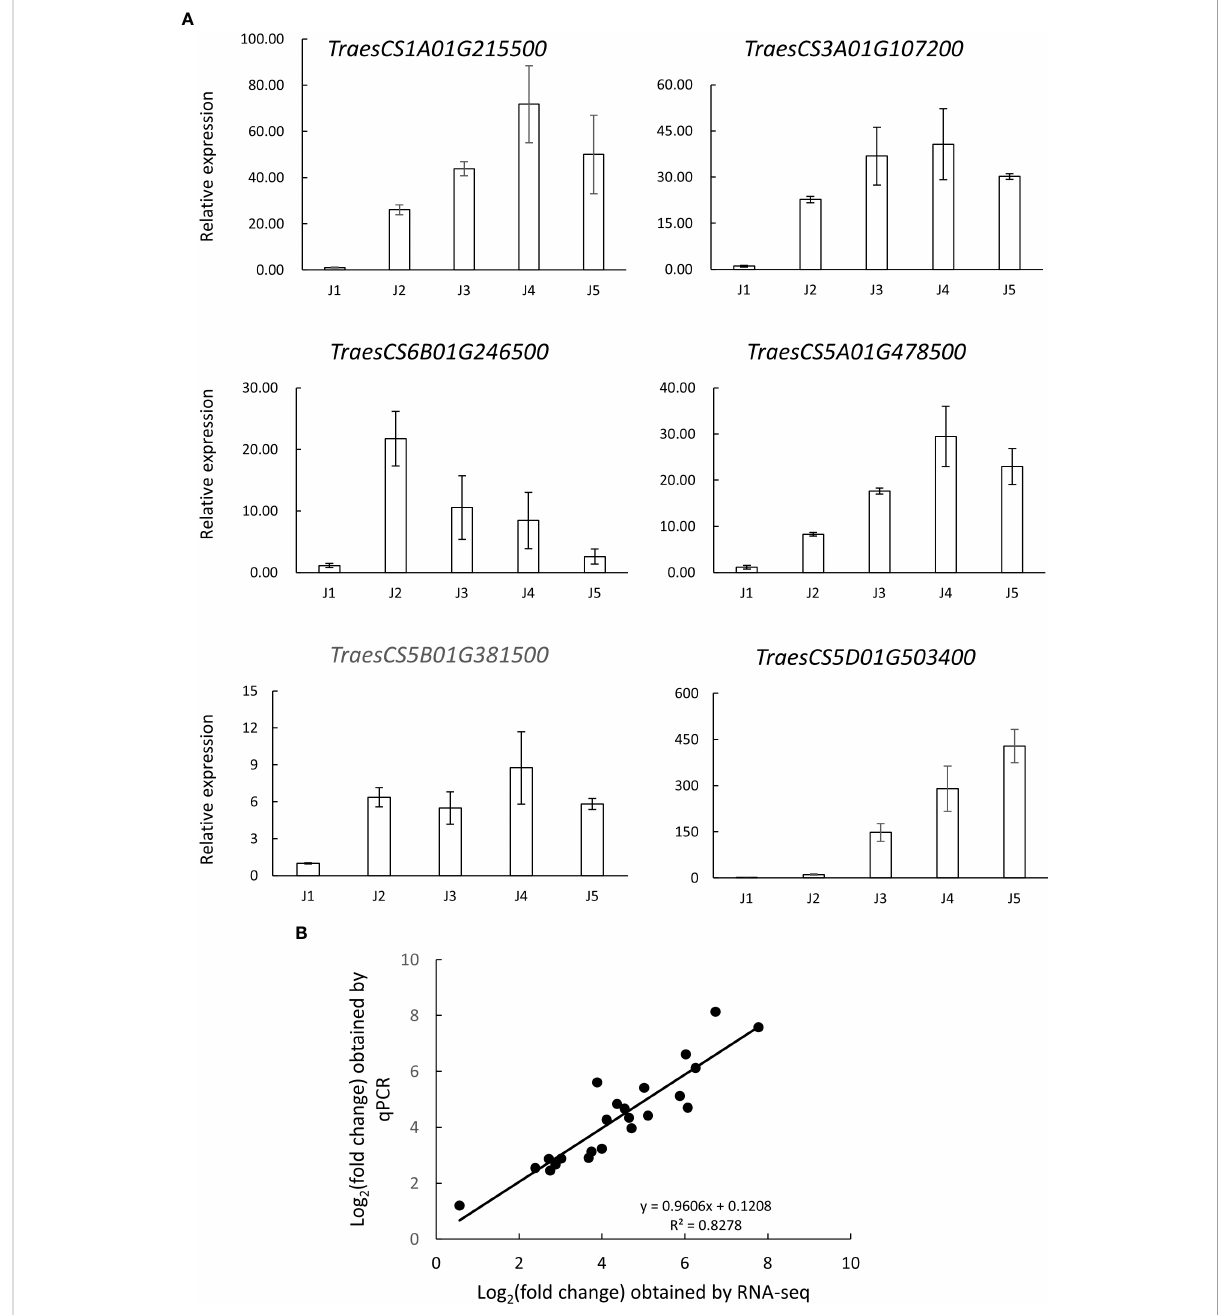
FIGURE 5 Veri fi cation of the expression pattern of selected genes via qRT-PCR analysis. (A) transcript levels of 6 selected genes in samples collected at different time points (J1-J5). The data are shown as means ± standard errors (SE) in three replicates. (B) Correlation analysis of the log2 of gene expression ratios obtained from RNA-seq data and qRT-PCR